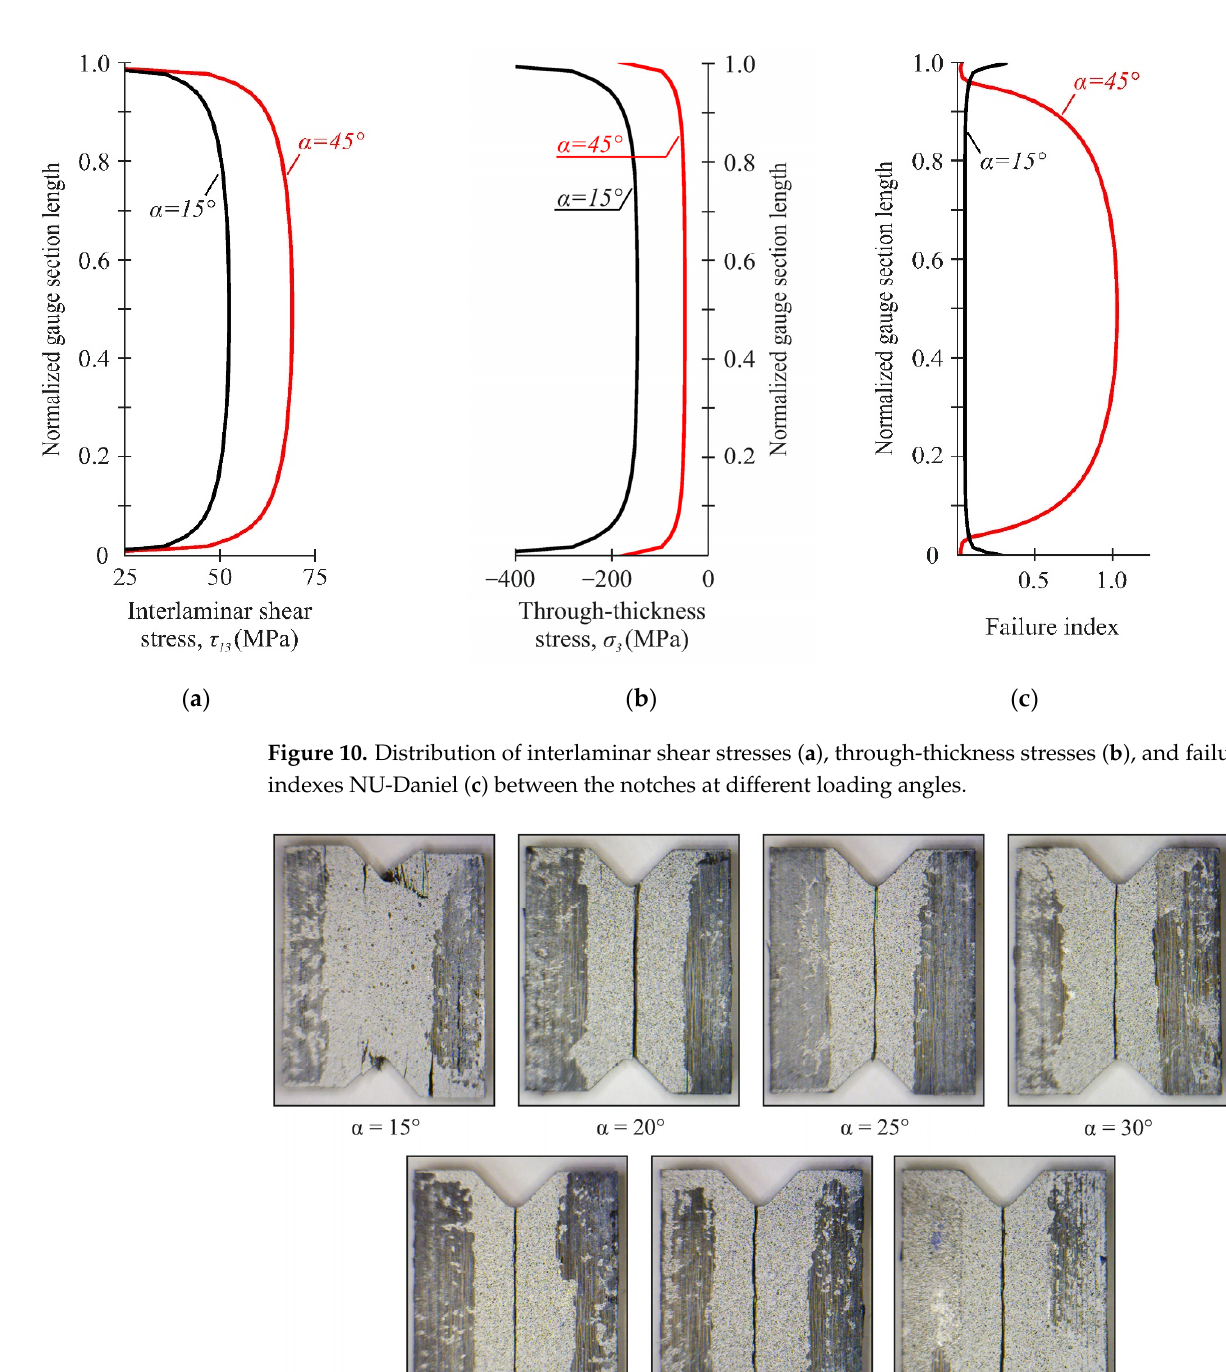
Figure 9. Distribution of interlaminar shear stresses ( a ), through-thickness stresses ( b ) and failure indexes NU-Daniel ( c ) on the face surface of the specimen at loading angle α = 15°.